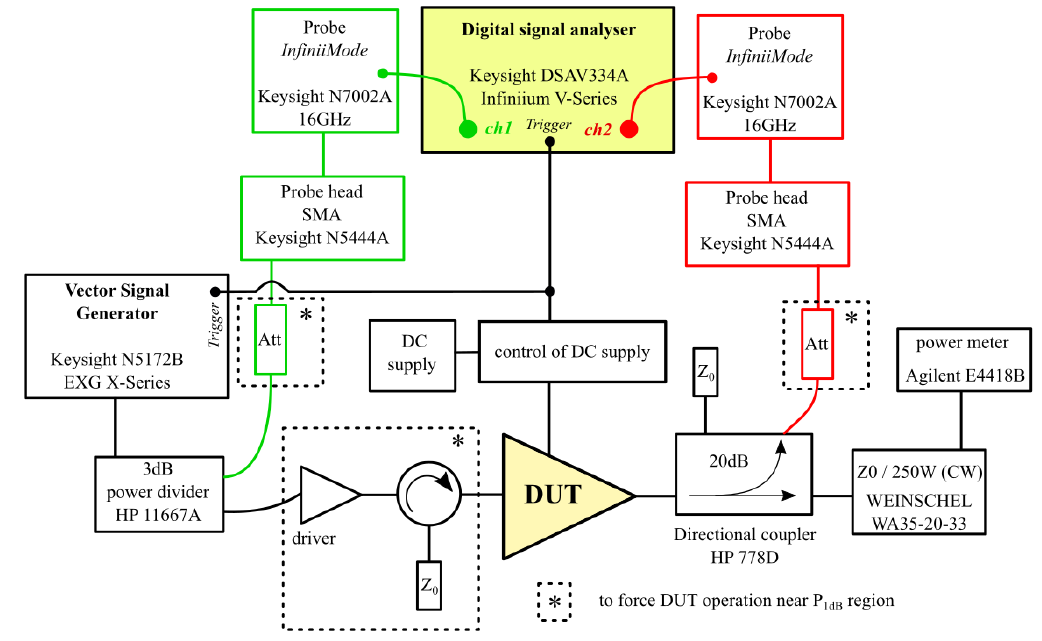
Figure 5. Measurement setup used for transmittance characterization with pulse trains.